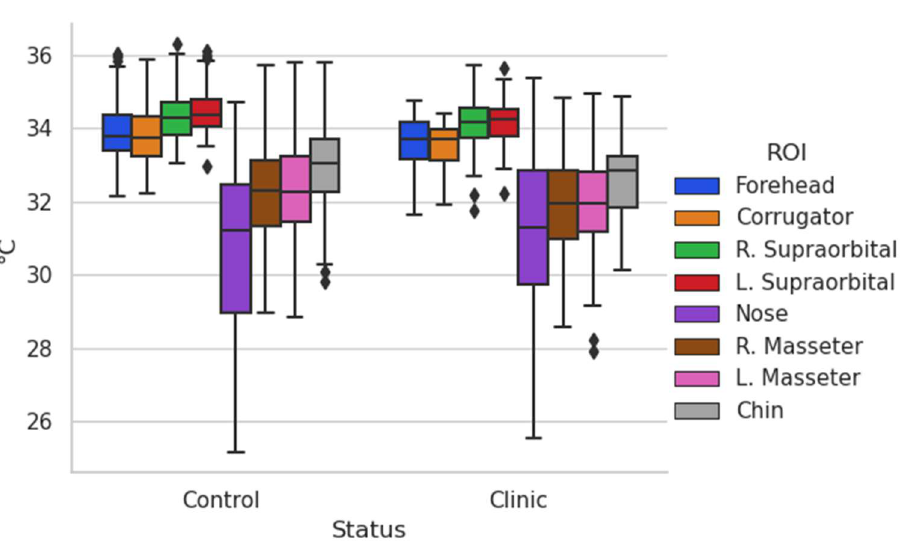
Figure 9. Control group and clinic group comparison. The thermal variation shown in Figure 9 according to the clinical and control group shows that there is a higher temperature in the face of the control group except for the nose, which can be produced by the amounts of stress to which people who are fighting against a disease or even be symptoms of it, are subjected. Studies have shown that people